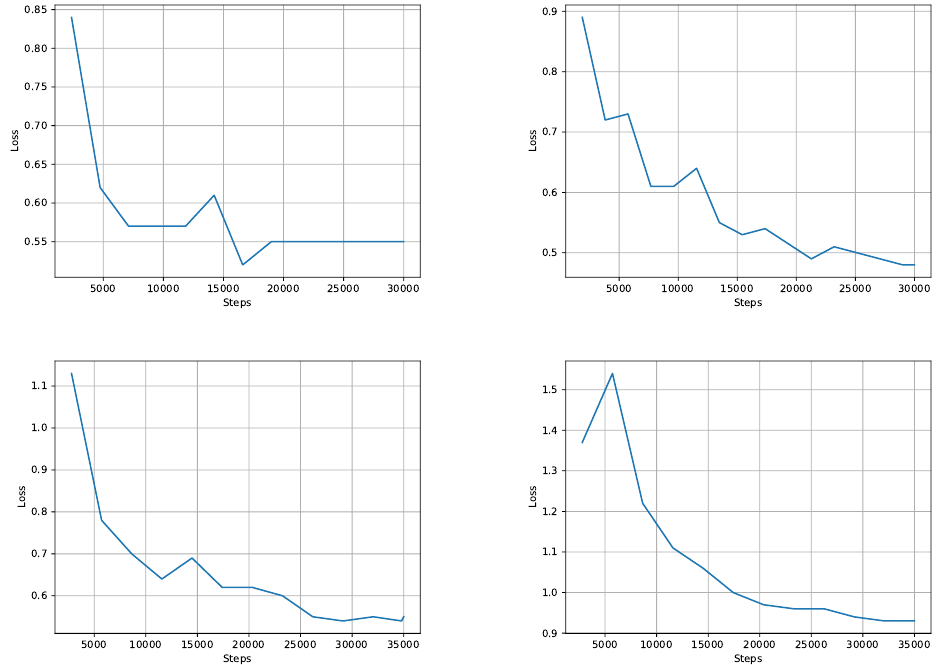
Figure 8. Loss of models during training. Top left: MobileNet-V1, top right: MobileNet-V2, bottom left: MobileNet Edge TPU and bottom right: MobileDet Edge TPU.